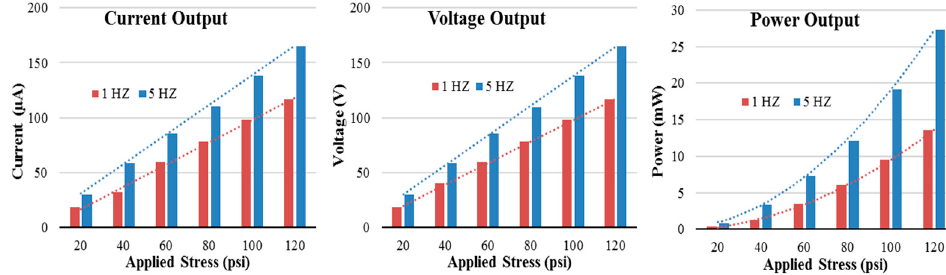
Figure 7. UTM Loading Scheme for Testing the HiSEC Module.